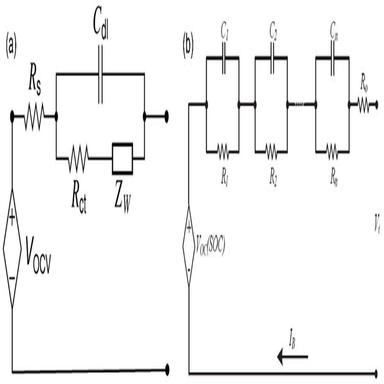
(a) Randles equivalent circuit model. (b) Expansion of the Warburg impedance with multiple RC networks in ECM . Reproduced with permission from IEEE.